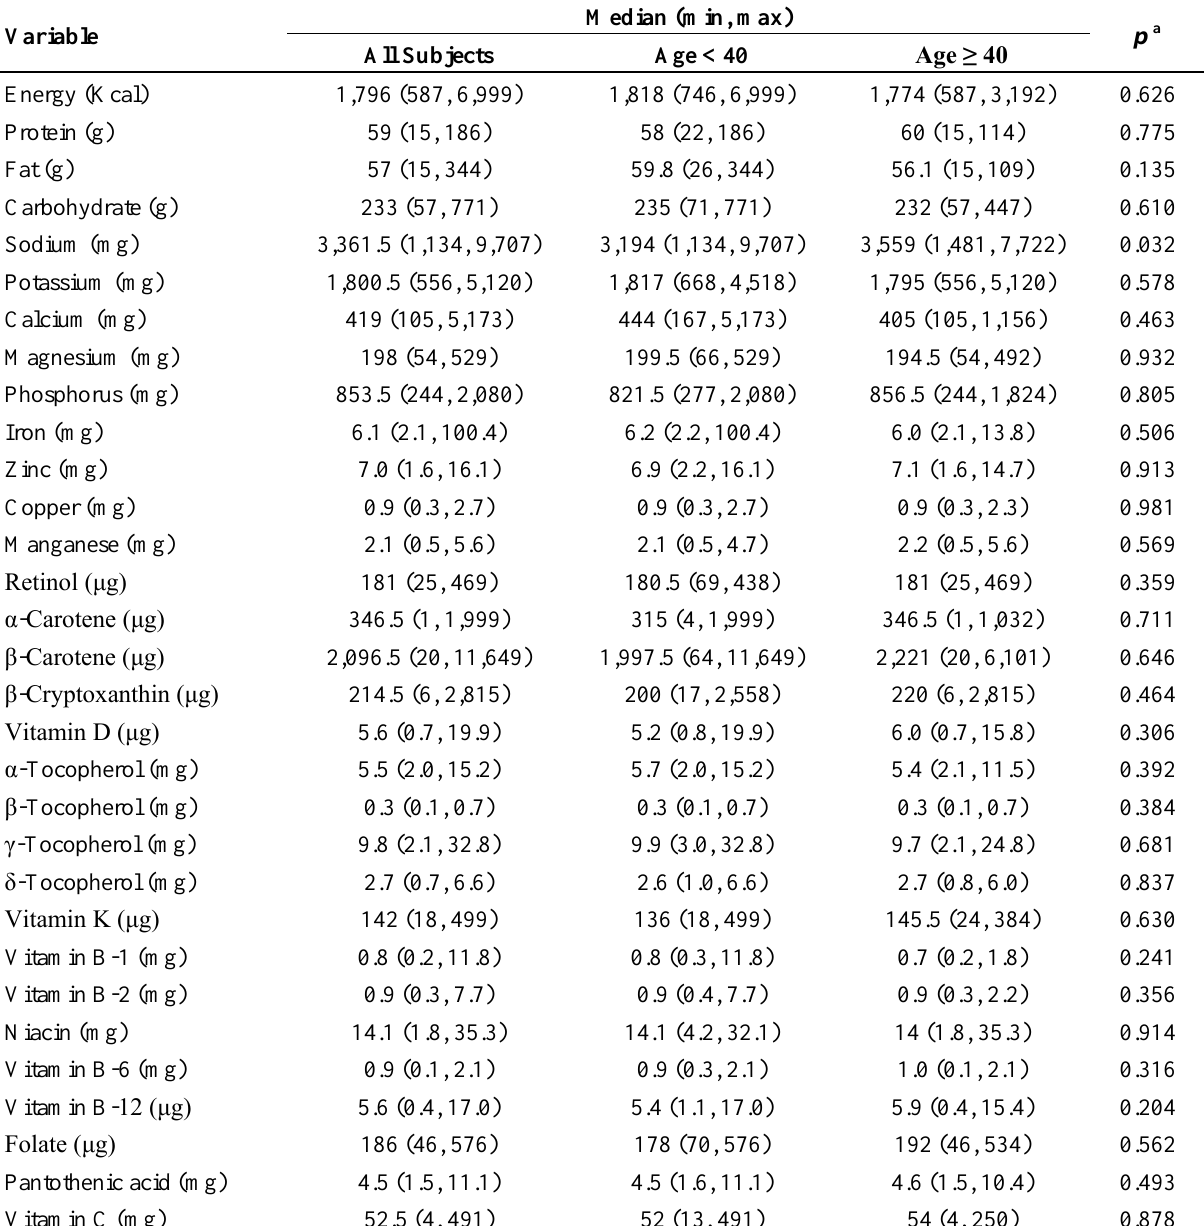
Table 2. Daily nutrient intakes of the